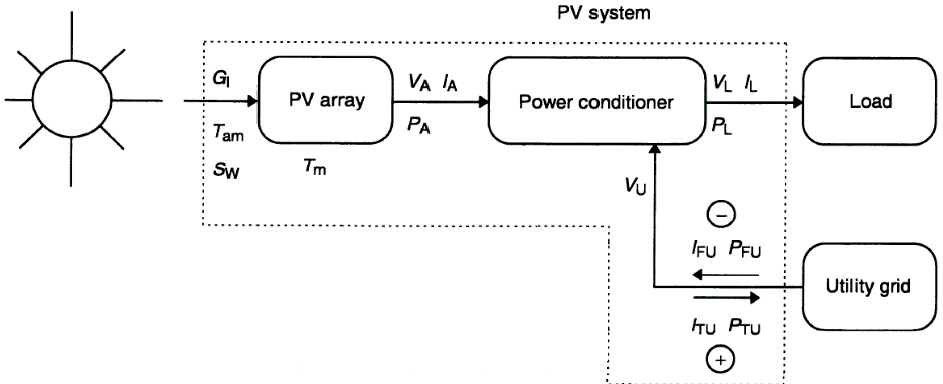
Figure 7. Diagram of parameters to be measured for the evaluation of the energy efficiency of the grid-connected photovoltaic (PV) system.